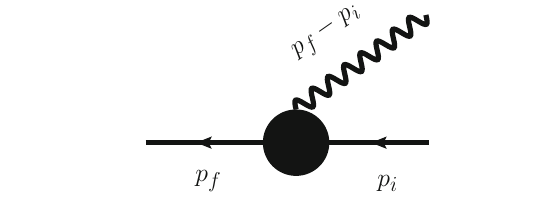
with σ νρ = i [ γ ν , γ ρ ] / 2 and (cid:6) 0123 = + 1. Notice that there is an overall different sign with respect to Ref.